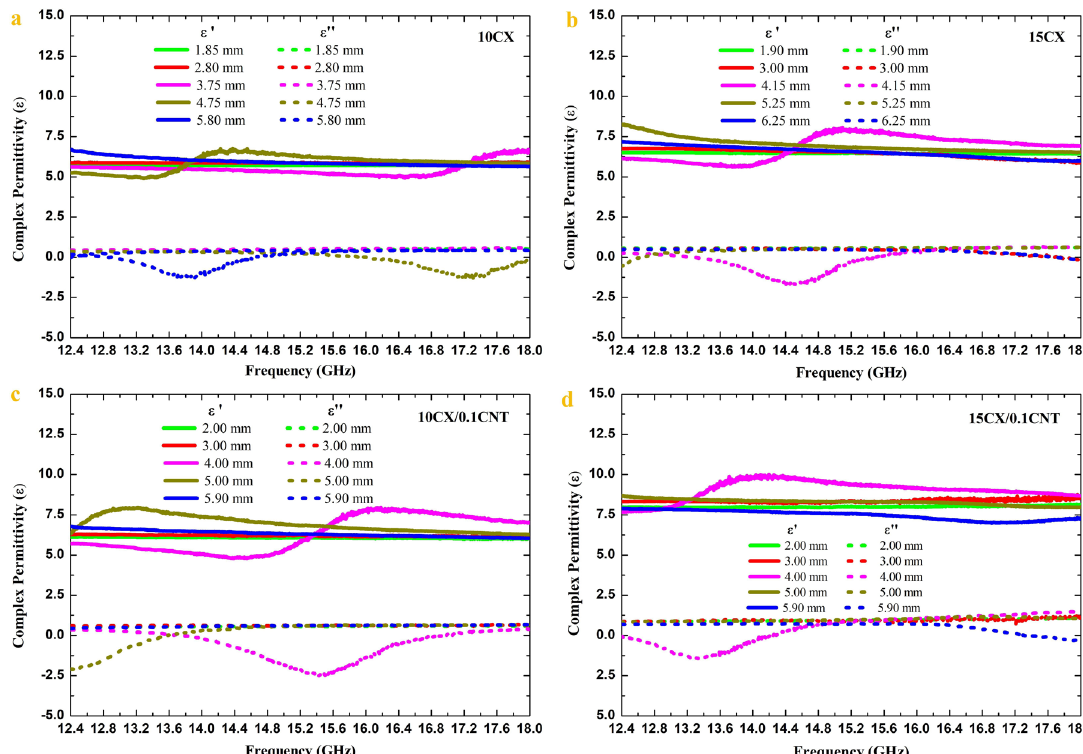
Figure 9. Complex permittivity of composites a) 10CX, b) 15CX, c) 10CX/0.1CNT, d) 15CX/0.1CNT.